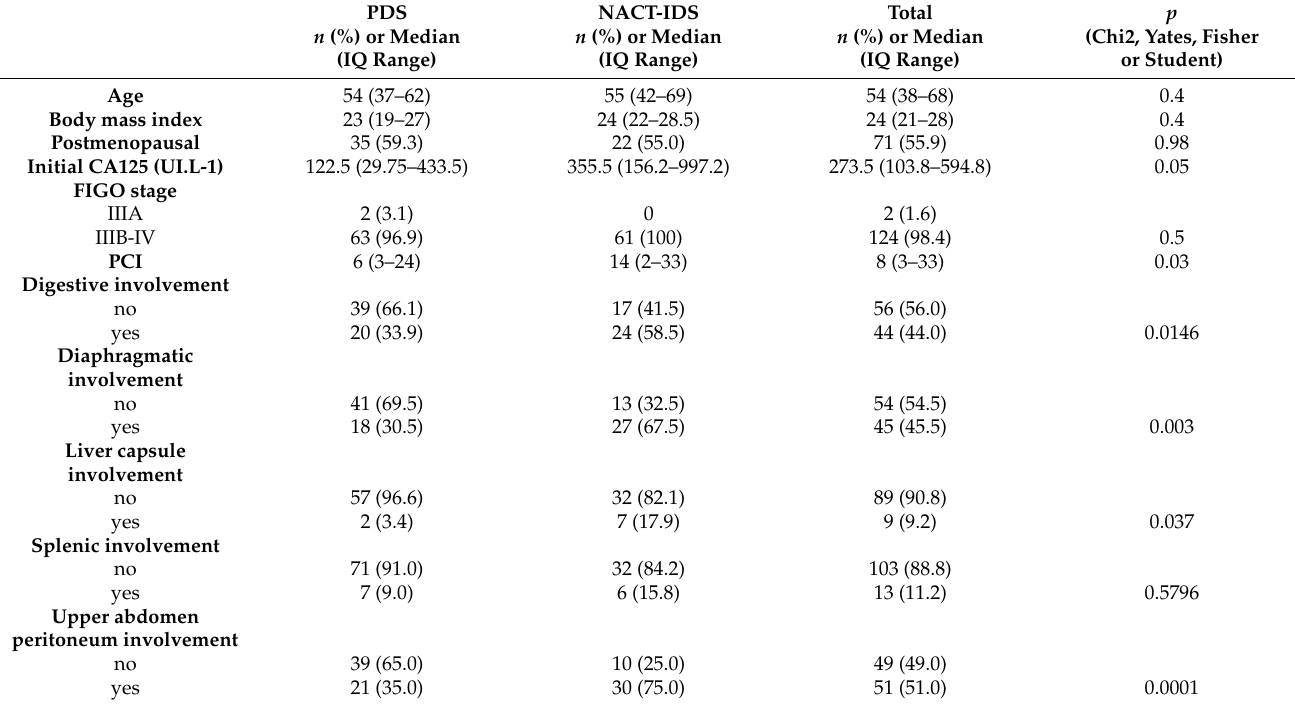
Table 1. Comparison of the PDS and NACT-IDS populations (disease